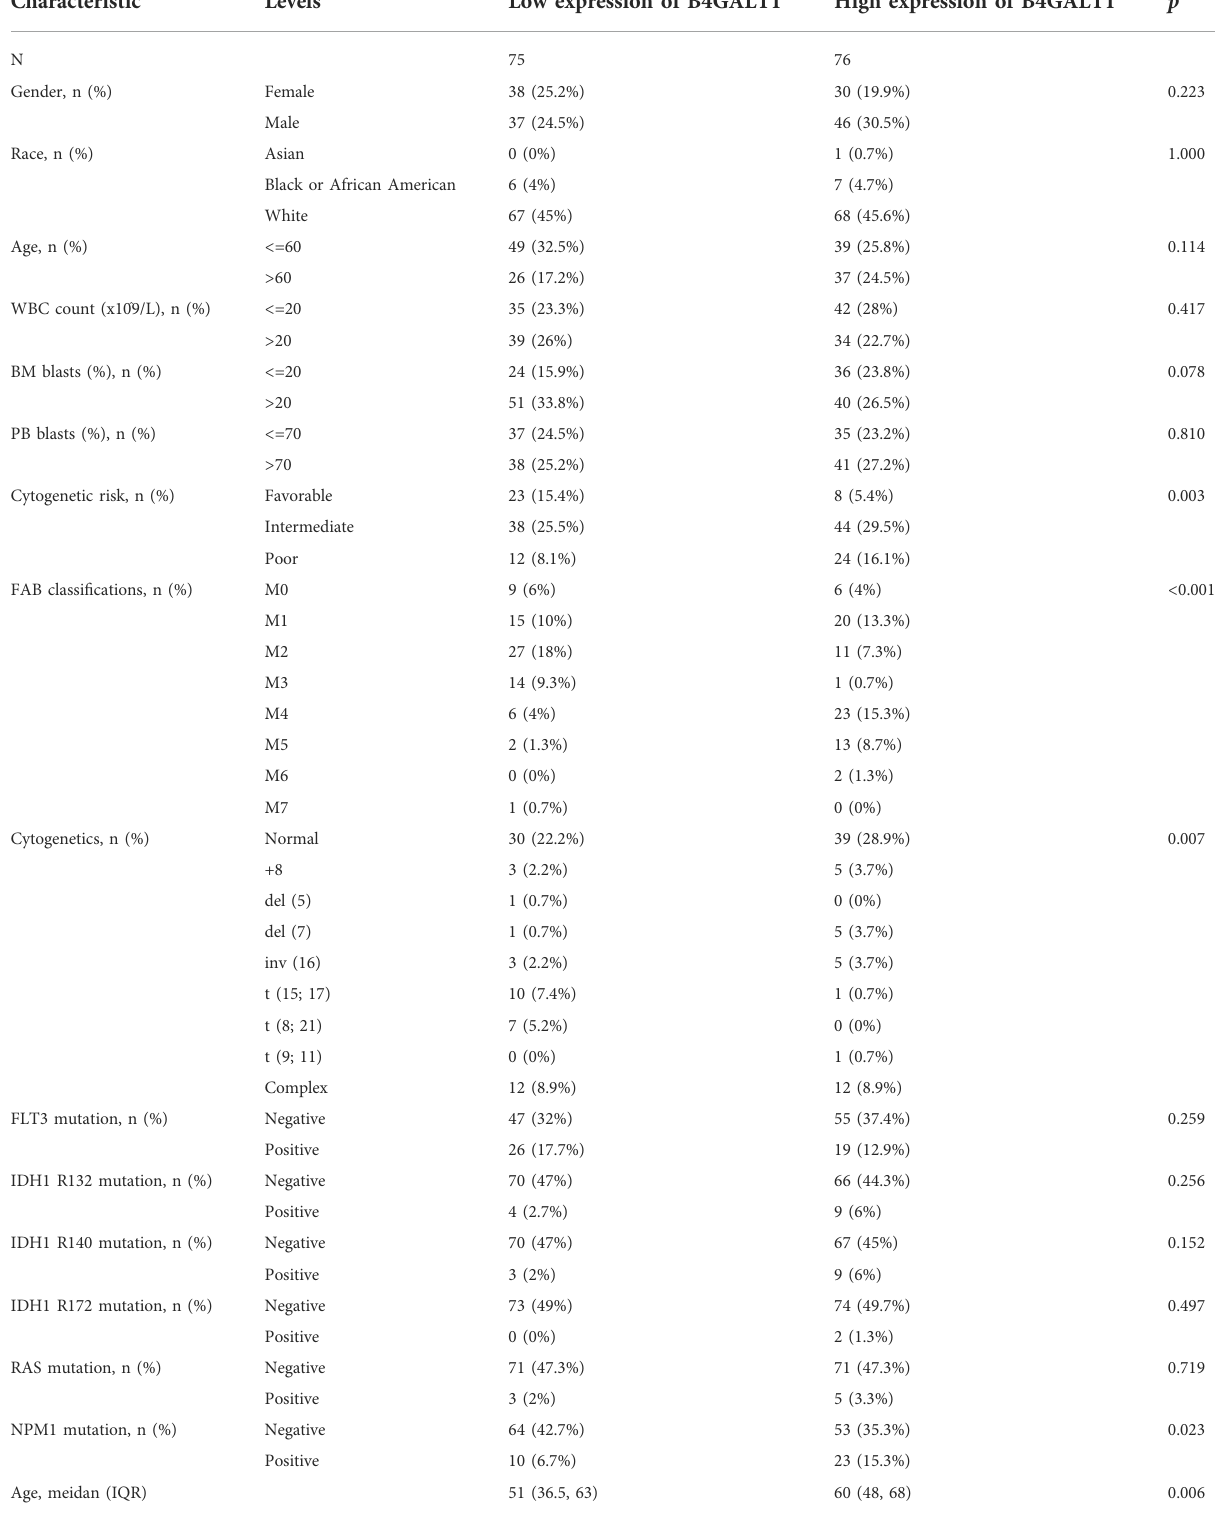
TABLE 1 Association between B4GALT1 expression and clinicopathologic features in LAML samples from the TCGA database.